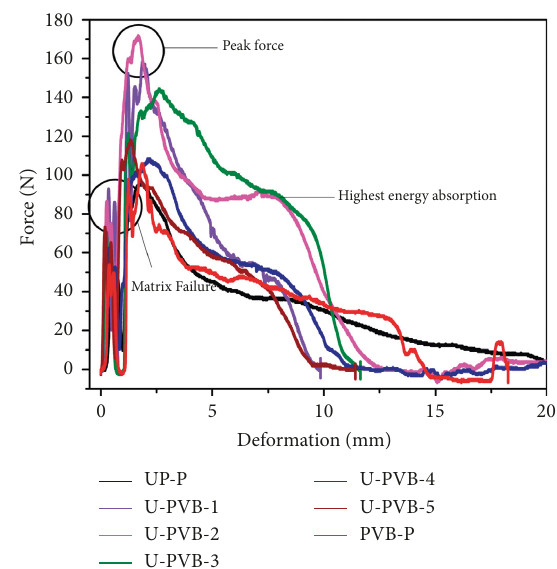
Figure 13: Force vs. deformation curve using instrumented Charpy pendulum tester.